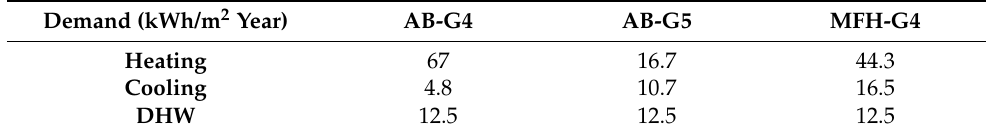
Table 2. Energy demands per unit area—Tabula project.